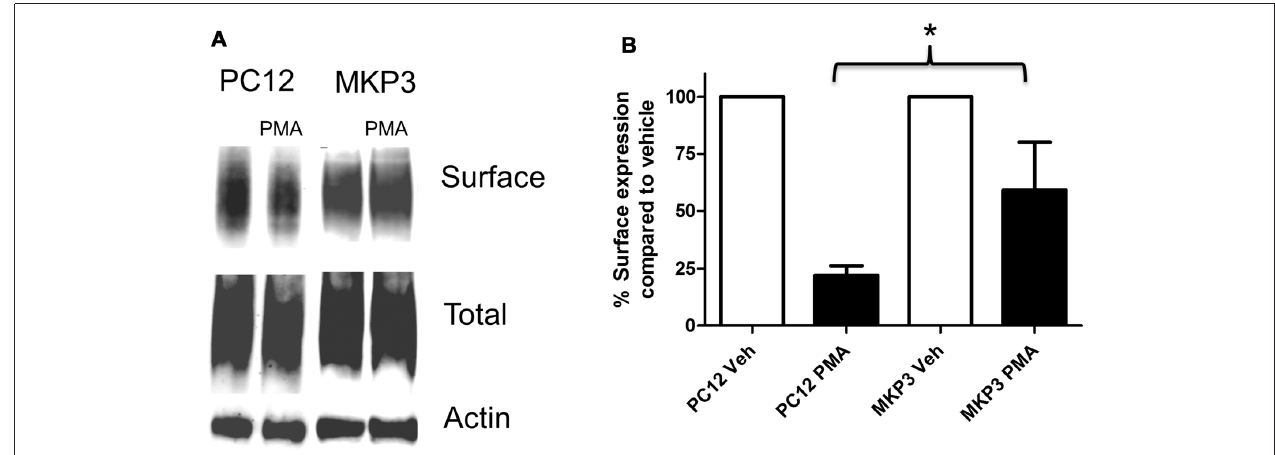
FIGURE 3 | PKC-mediated decrease in NET surface expression is attenuated by MAP kinase phosphatase 3 (MKP3). Cell surface biotinylation was performed on naïve (PC12) and MKP3-expressing (MKP3) PC12 cells following PKC activation by PMA (1 µ M) for 30 min. NET surface expression was visualized by immunoblotting (A) . Band densities were quantified from three independent experiments (B) . Statistical significance was determined employing two-way ANOVA with Bonferroni post hoc analysis ( ∗ p < 0.05 comparing surface expression following PMA treatment).